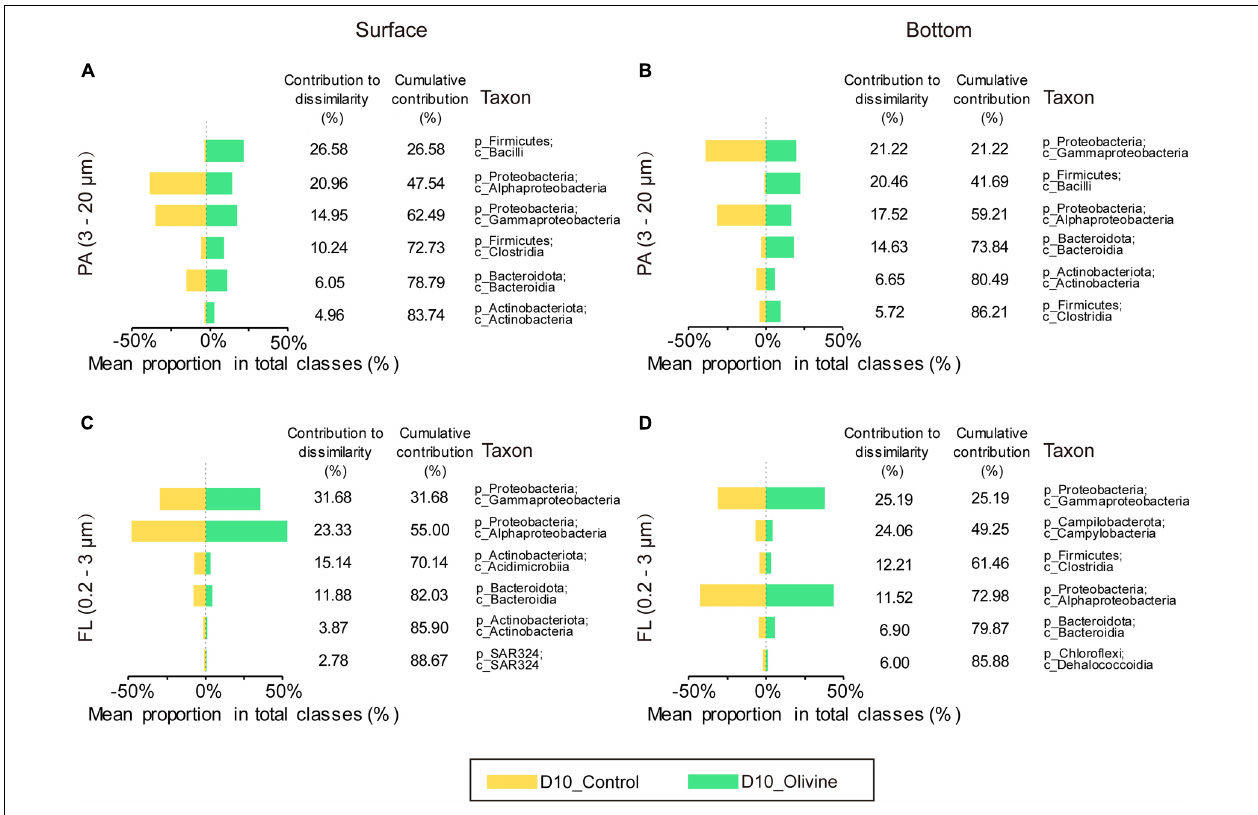
FIGURE 5 | Contributions of the top six particle-attached (A,B) PA, 3–20 µ m and free-living (C,D) FL, 0.2–3 µ m bacteria classes to community dissimilarities after 10-day incubations in control and olivine-added seawater from surface (A,C) and bottom layers (B,D) of the sampling